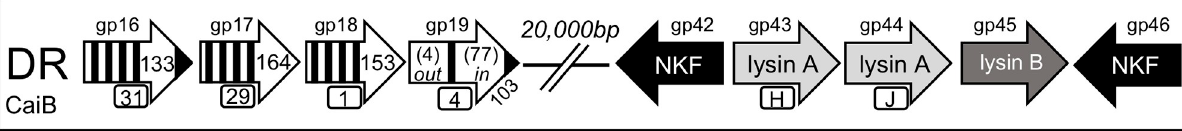
Fig 10. Genomic organization a lysis cassettes with a lysA and lysB in the same location and four transmembrane genes at a distal location. The genomic structure is shown and the key to the schematic is presented in Fig 1. The direction of transcription of the gene is represented by the arrowhead. The identity of each protein is shown above the